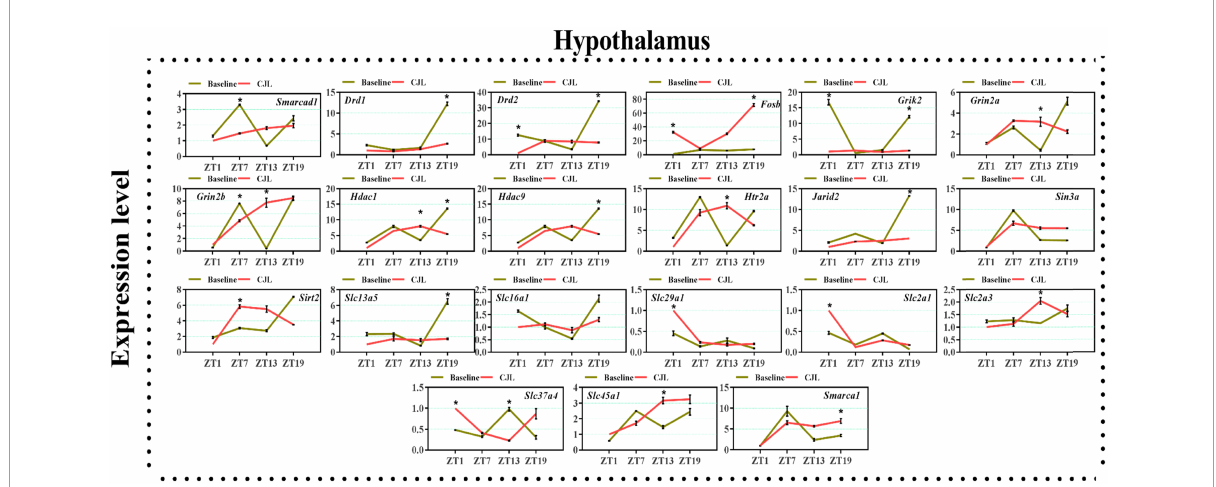
FIGURE5 Chronic jetlag (CJL) altered mRNA levels of genes associated with psychiatric disorders in the hypothalamus. This figure shows mRNA levels in hypothalamus extracts from baseline and CJL treated animals ( n = 3 per group), as assayed by three independent qPCR assays, at four different time points (ZT1, ZT7, ZT13, and ZT19). Results are expressed as mean ± SEM. * P < 0.01, two-way ANOVA.